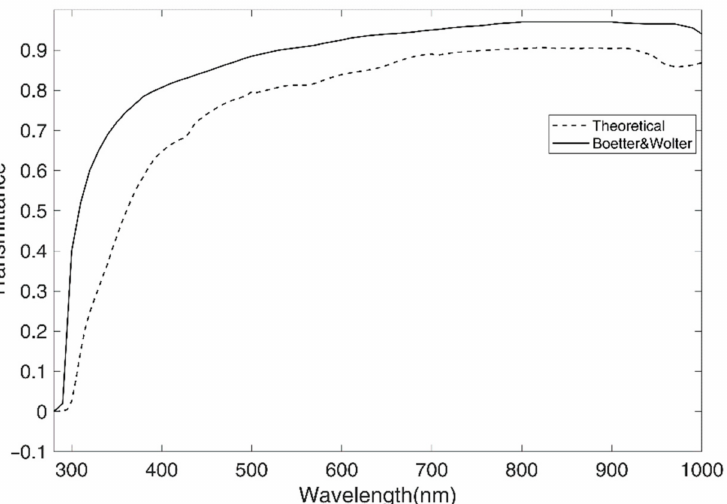
Figure 4. Comparison of the Boettner and Wolter [1] experimental result of total transmittance cornea with our calculated results from the absorption coefficients and mean thickness of corneal